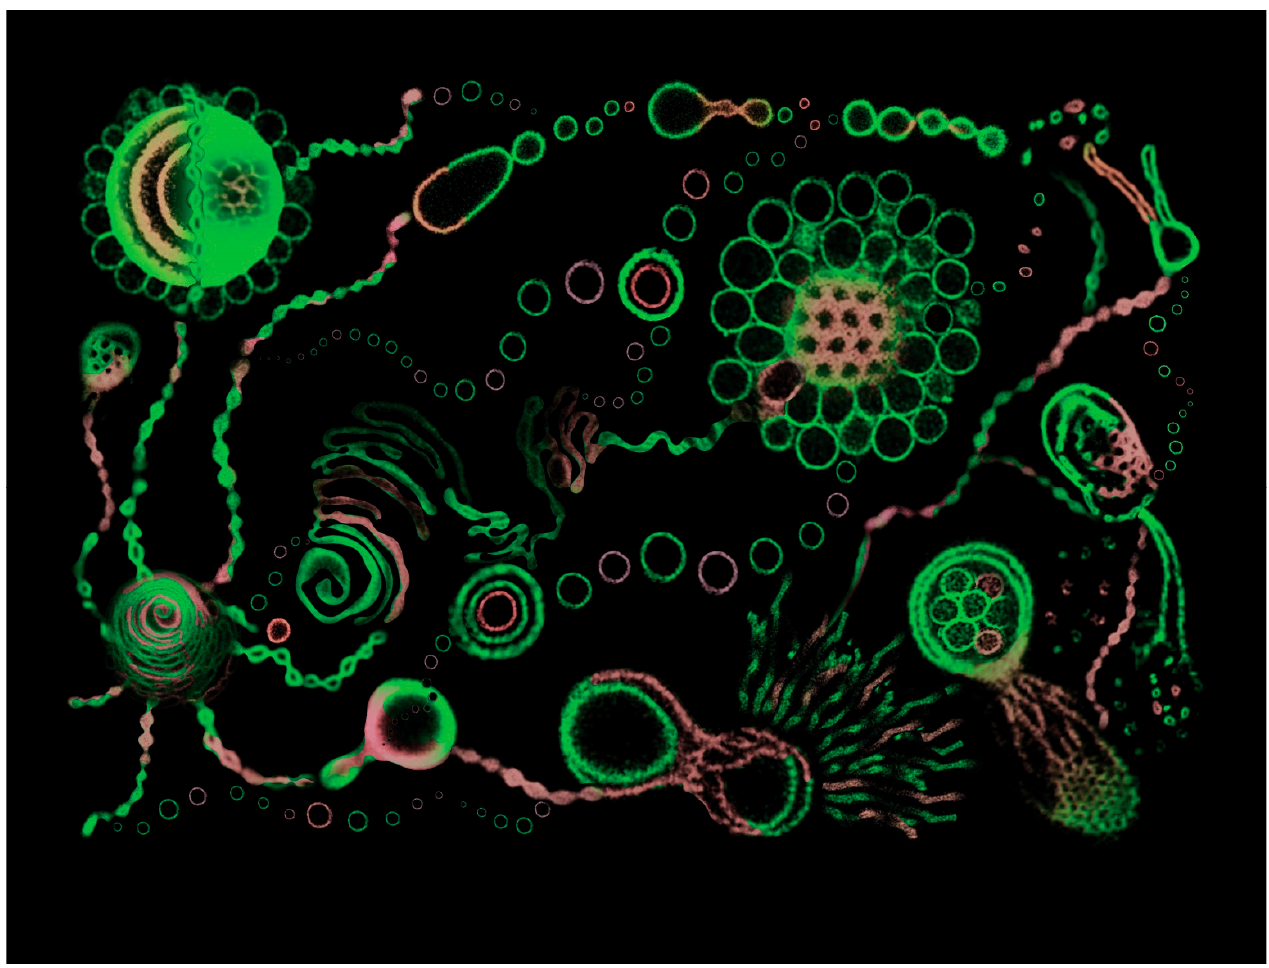
Figure 28. Mechanism of disassembly of large dendrimersomes by photocleavage and their reassembly into smaller dendrimersomes [245]. Copyright © The Royal Society of Chemistry.